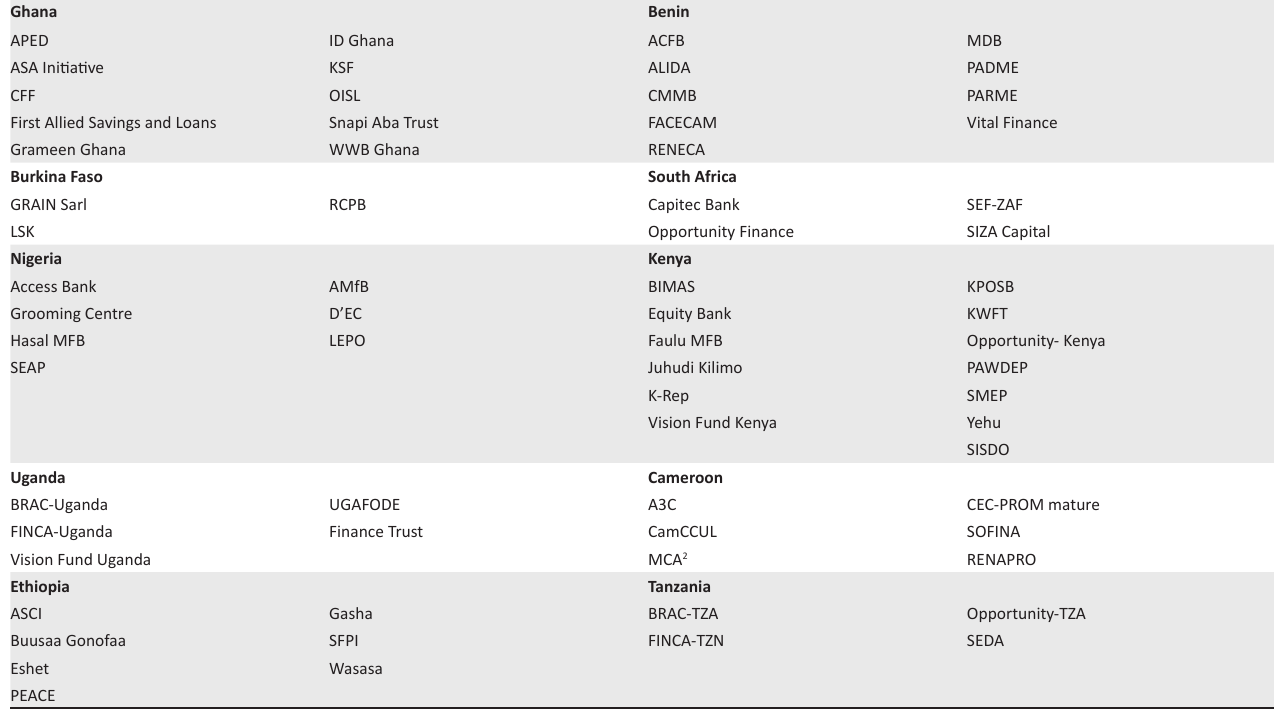
TABLE 1-A1: List of microfinance institutions and countries included in the study.